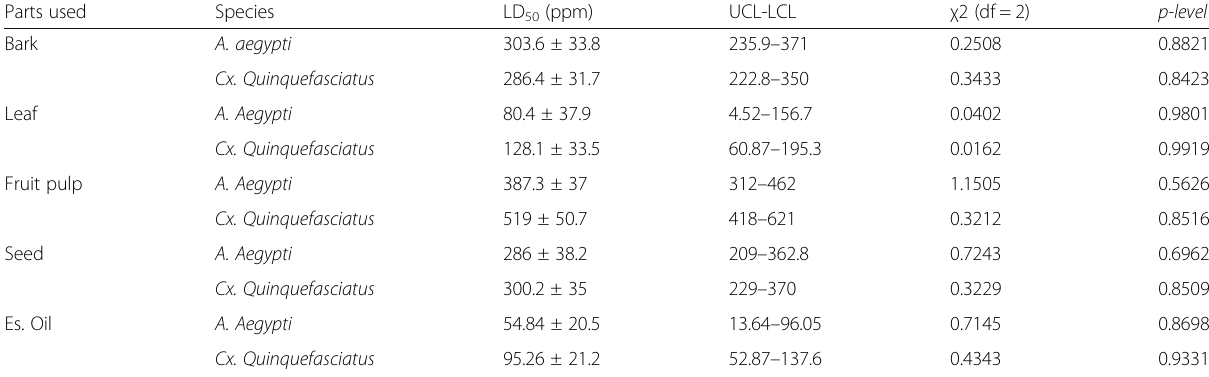
Table 7 LD50 and other statistical analysis of S. caryophyllatum plant extracts and essential oil against fourth instar larvae of Ae. aegypti and Cx. quinquefasciatus Parts